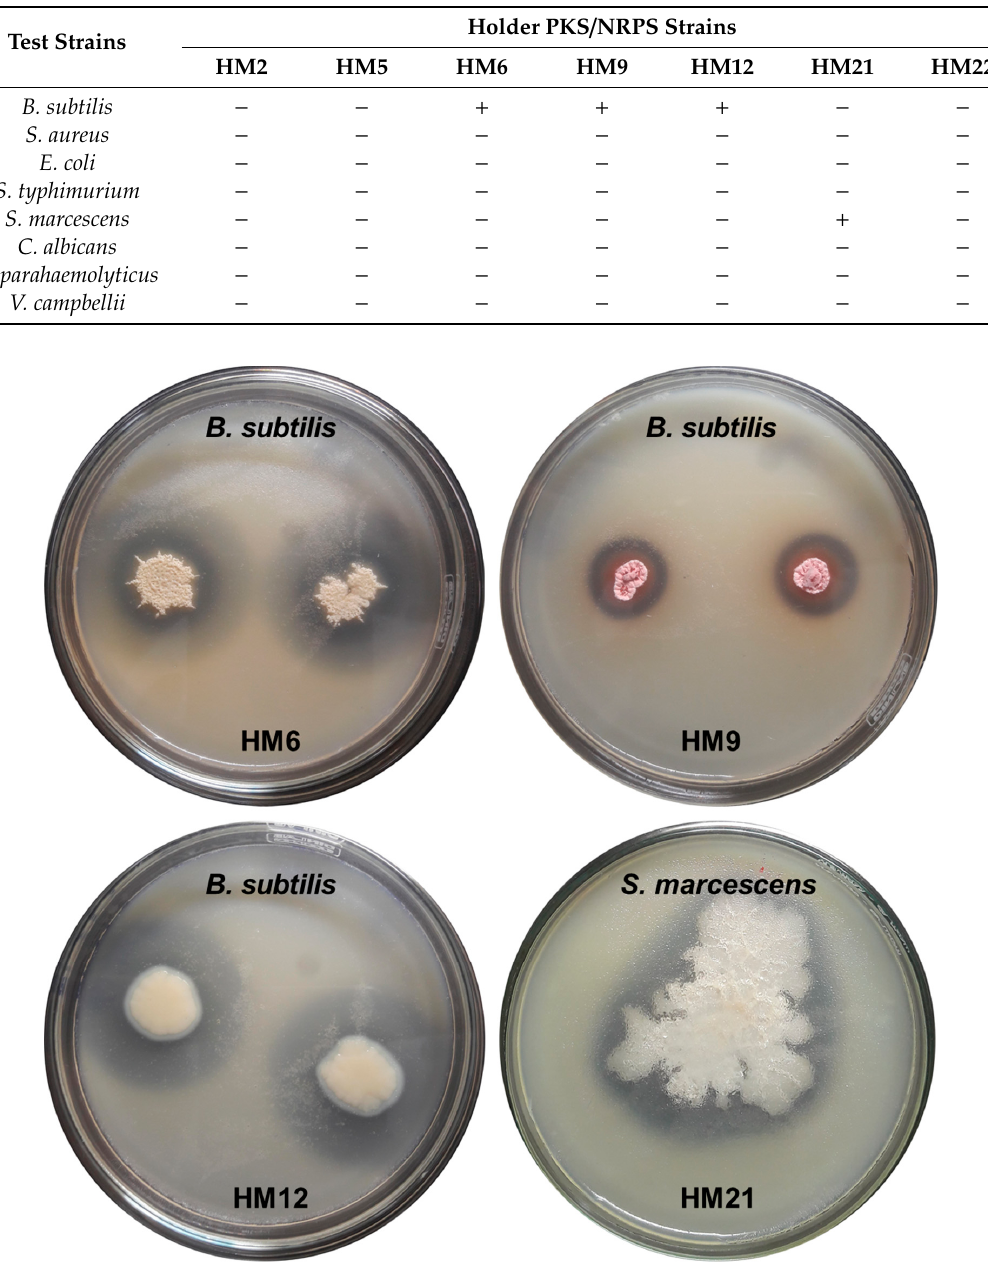
Table 2. Primary antibiotic producer strains by colony picking method (Notation: ( + ) inhibition zone observed; ( − ) no inhibition zone observed).